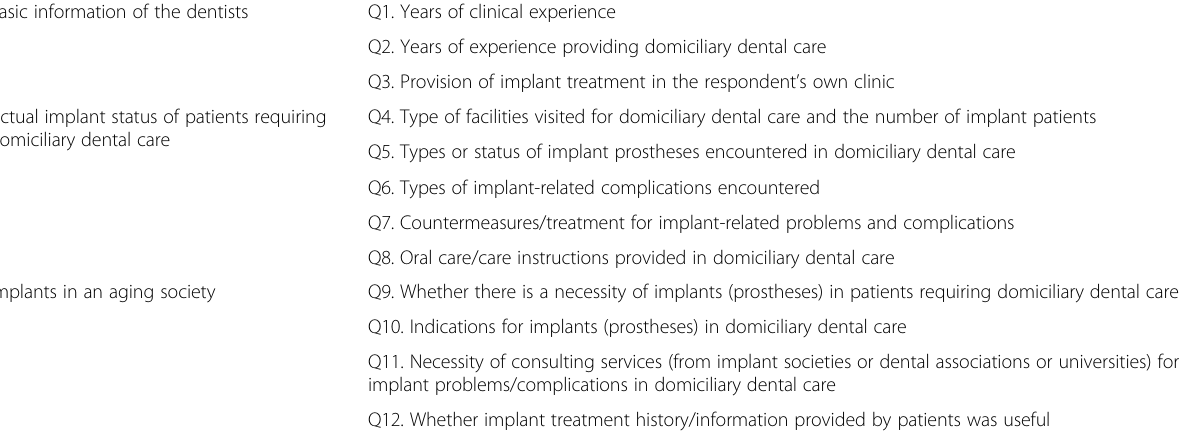
Table 1 Summary of the questionnaire sent to dentists who provided domiciliary dental care Basic information of the